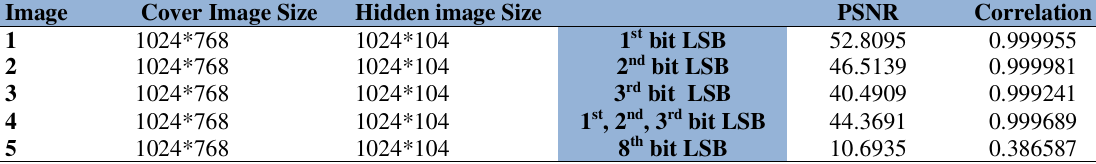
PSNR and correlation results for hidden secret text of (104 KB) Image